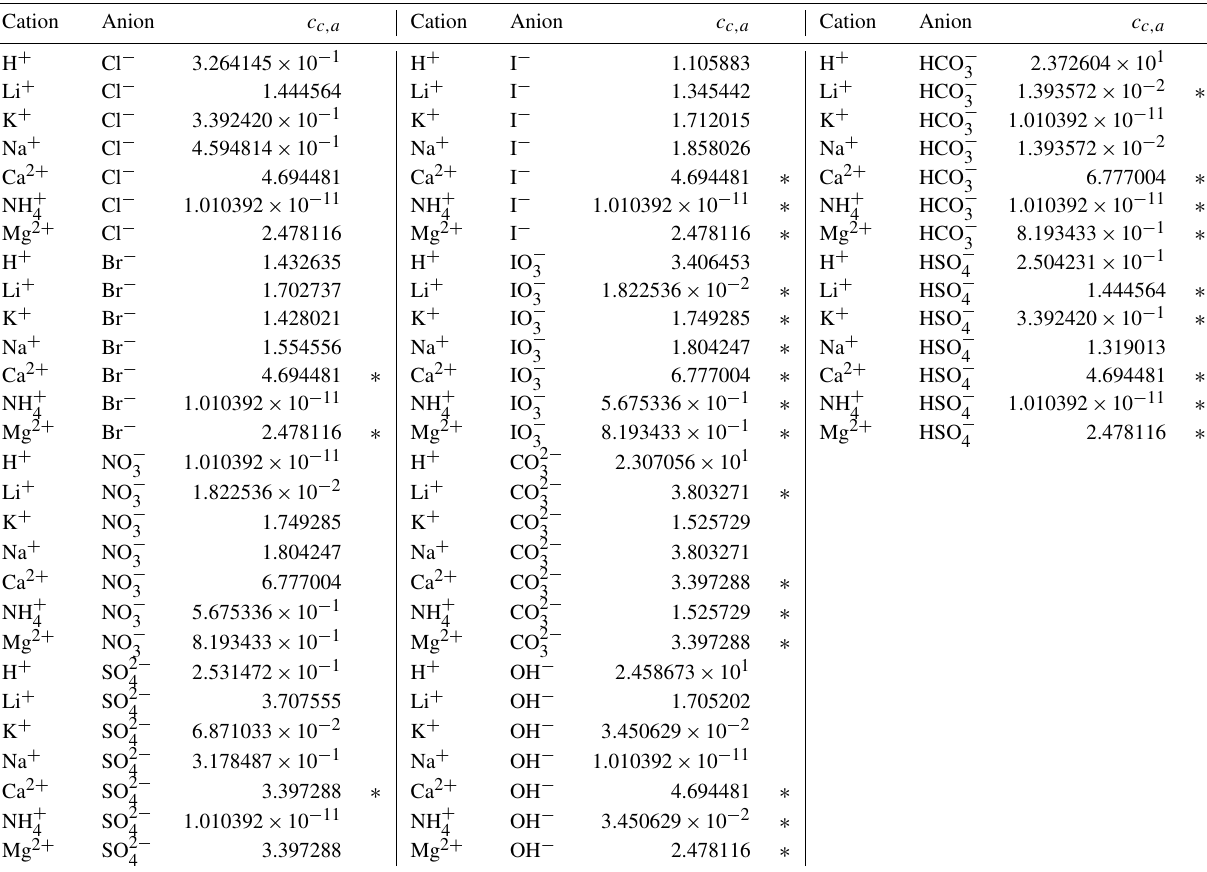
Table 7. AIOMFAC-VISC cation–anion pair coefficient, c c,a . a,b